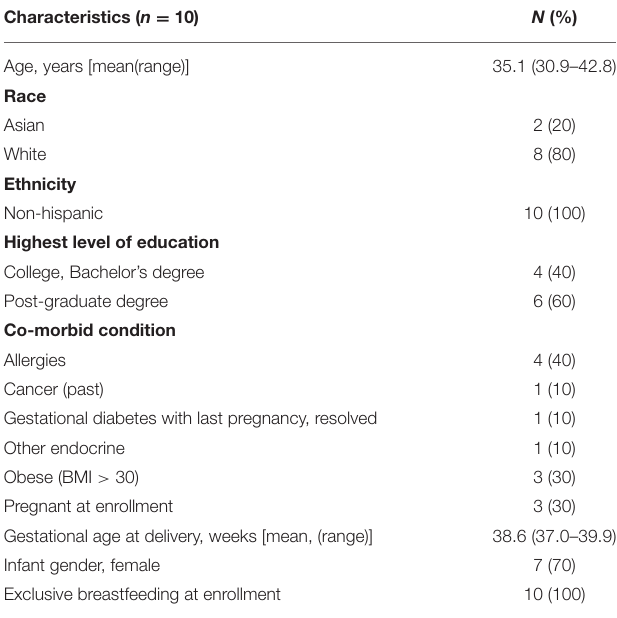
TABLE 1 | Participant characteristics of 10 lactating mothers receiving the primary series and booster vaccination against